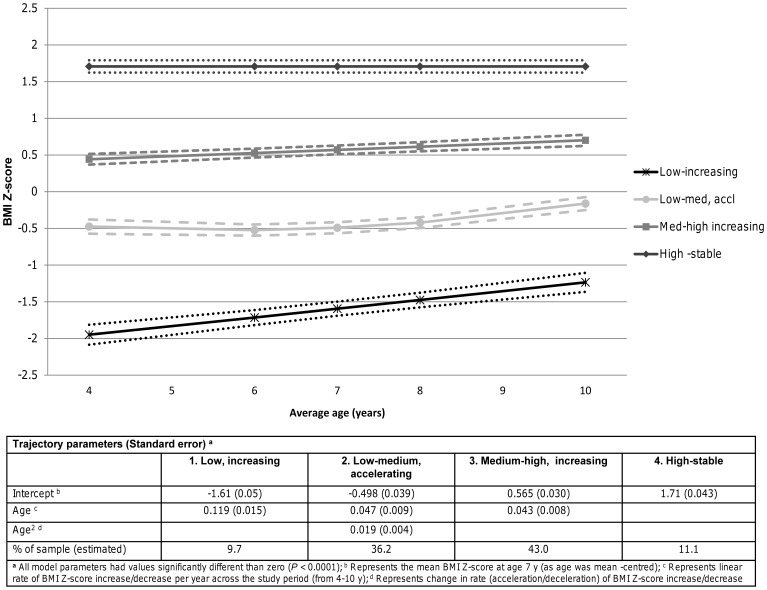
Estimated weight change trajectories and 95% confidence intervals in the QLSCD from 4–10 y of age (n = 1566).